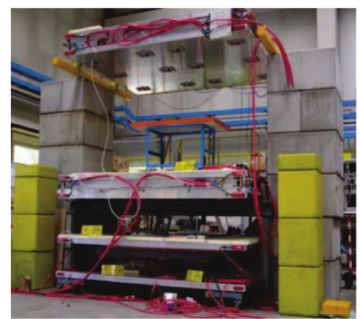
Fig. 4. Muon tomography system of the PREDIS project.